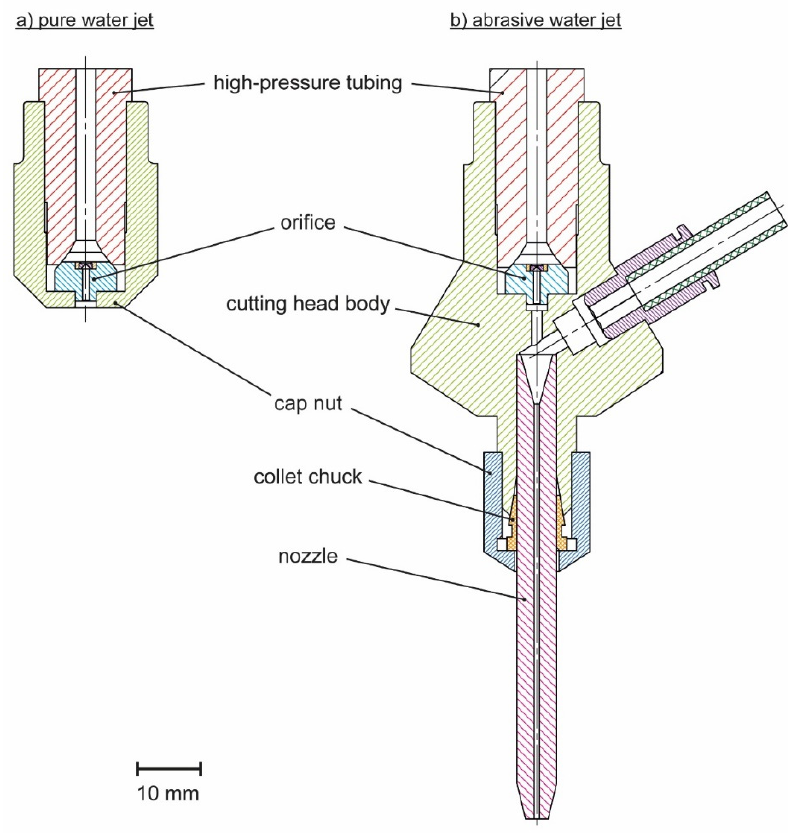
Figure 1. Comparison between a cutting head for pure water jet ( a ) and abrasive water jet cutting ( b ).